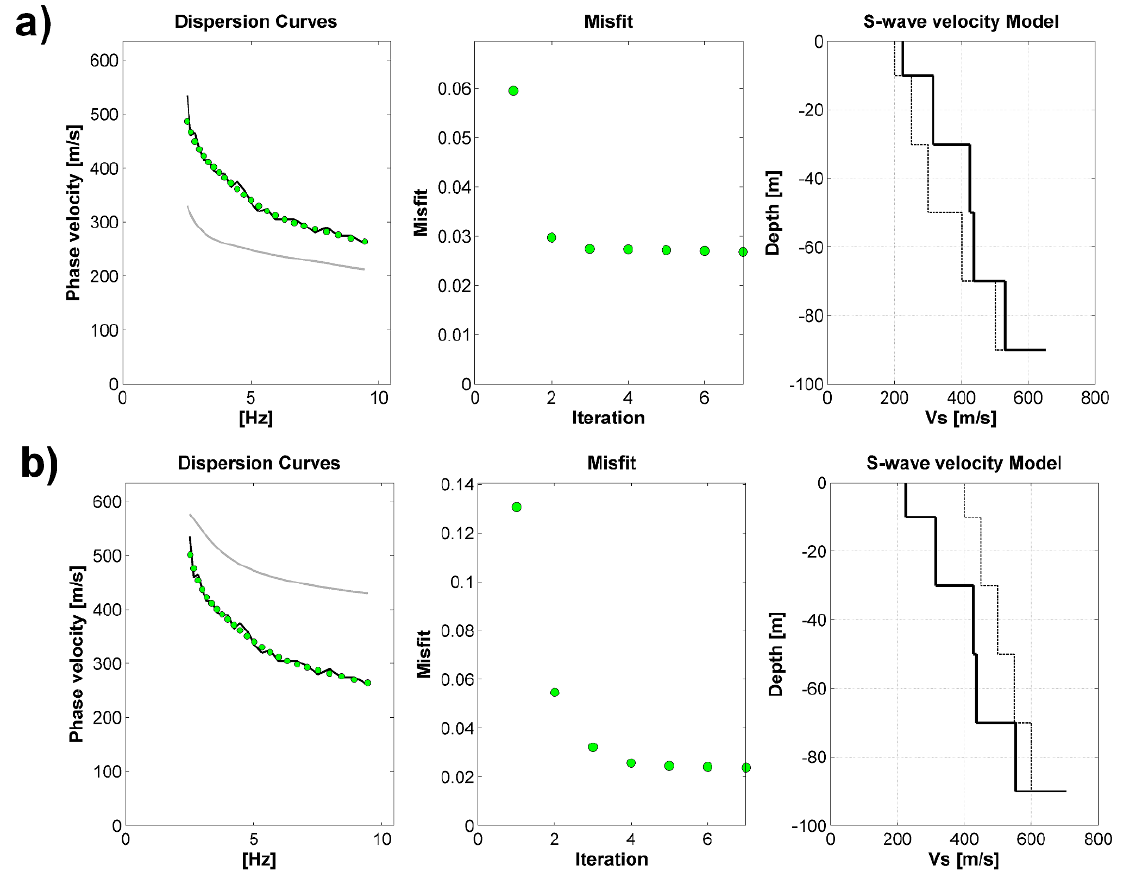
Figure 9. Results of the inversion analysis starting from different input models. ( a ) Under- estimated input model. In the left-panel are shown the experimental phase velocities ( black line ), those for the best-fit model ( green dots ), and the dispersion curves for the input model ( gray line ). In the middle-panel is shown the misfit for each iteration ( green dots ). In the right-panel are shown the S-wave velocities for the input ( thin line ) and final best-fit ( thick line ) models. ( b ) same as ( a ), but for an over-estimated input